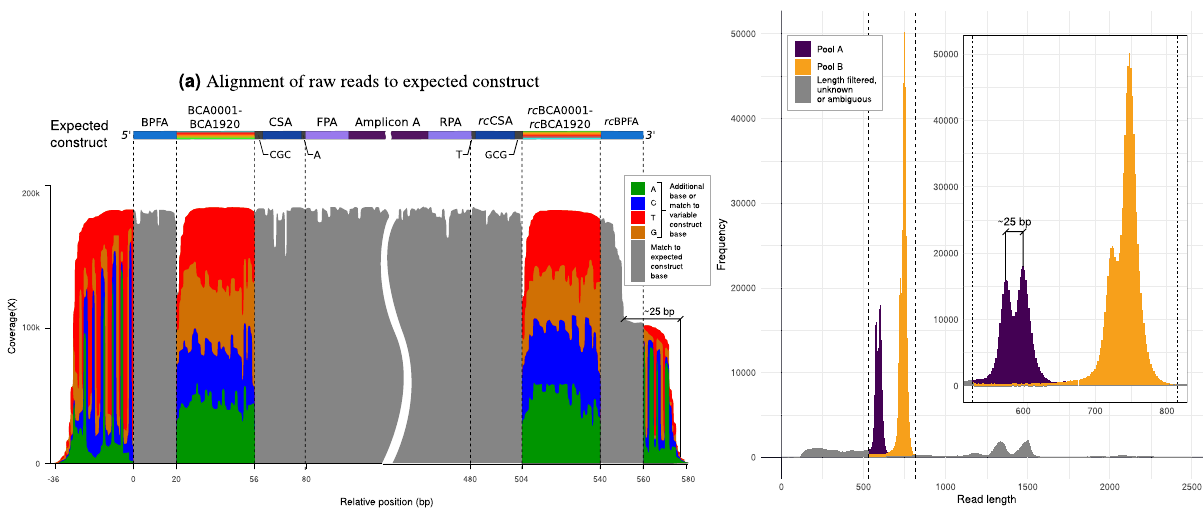
Figure 3. Analysis of raw sequencing output. ( a ) Alignment of raw reads to the expected barcoded construct for amplicon A, which includes forward and reverse species-specific primers (FPA/RPA), along with a highly- variable barcode region, flanking sequences CSA and BPFA, and auxiliary sequences CGC and A, or the reverse complement (rc) thereof. Only reads aligning in the forward sense are shown to highlight that about half the reads are trimmed ~25 bp shorter at the end. ( b ) Read-length histogram of raw reads with ground truth assignment to pools A or B. Dotted lines show the window used for length filtering. Reads outside the window or with either unknown or ambiguous ground truth were not considered and are shown in grey. (b-inset) Zoom in on the valid length window, showing secondary peaks (bimodality) due to imperfect adapter